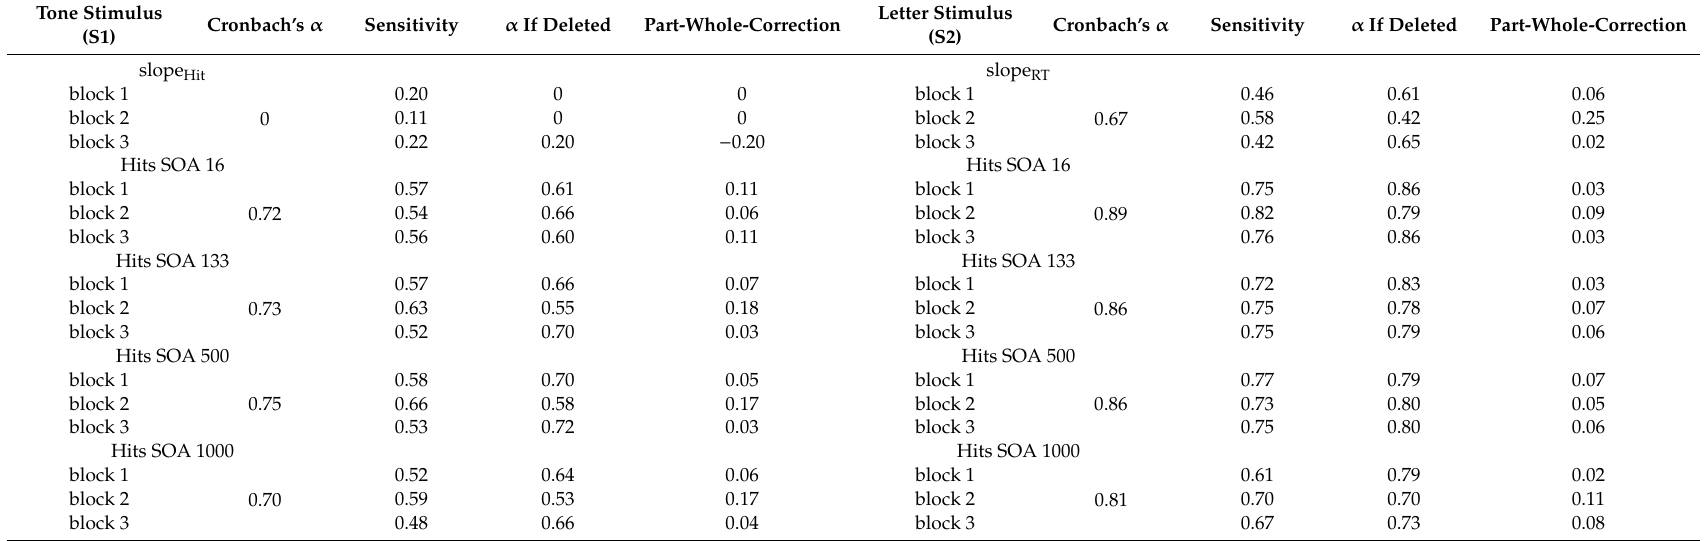
Table 4. Cronbach’s α reliability analysis for the slope of the stimulus-onset asynchrony (SOA) accuracy rates function and accuracies in each of the di ff erent SOA conditions and